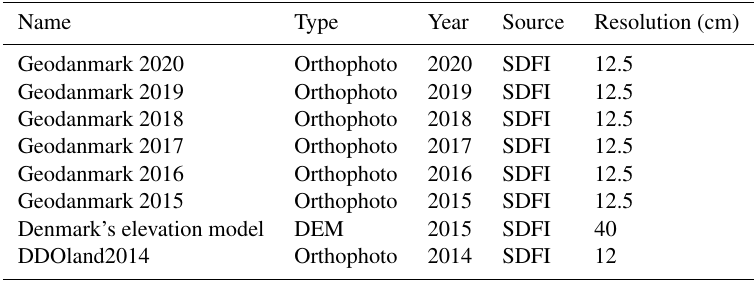
Table 1. Freely available data from the Danish Agency for Data Supply and Infrastructure (SDFI) used in the landslide mapping. See “Data availability” section for links to the datasets. Adapted from Svennevig et al. (2020b).